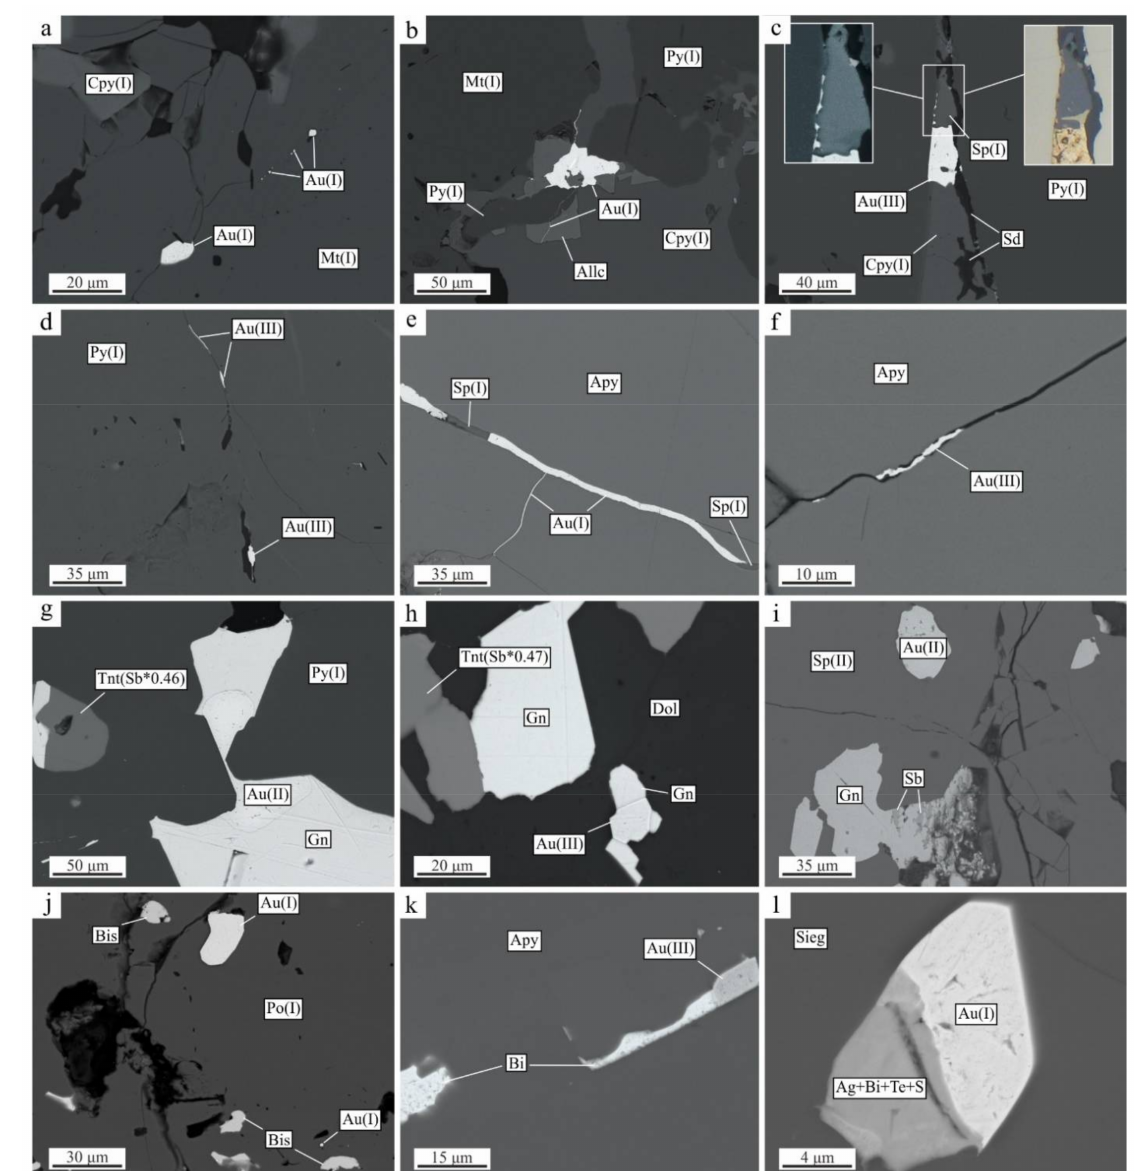
Figure 17. A selection of backscattered electron micrographs showing native gold grains from various districts of the Kultuma deposit. ( a ) The native gold (I) (950‰) micro inclusions in micro fractures in the magnetite (I); ( b ) the native gold (I) (950‰, Hg—0.61 wt.%) grain in contact and pyrite (I) (and gold micro veinlets in alloclasite euhedral grains); ( c ) chalcopyrite (I) and sphalerite (I) in a micro veinlet along pyrite (I) euhedral grains and late native gold grain (III) (650‰, Hg—5.2 wt.%); ( d ) the native gold (III) (620‰, Hg—3.1 wt.%) micro inclusions in micro fractures in the pyrite (I); ( e ) micro veinlet of the native gold (I) (790‰, Cu—1.5 wt.%) with sphalerite (I) in arsenopyrite; ( f ) native gold (III) (620‰, Hg—3.0 wt.%) micro veinlet in arsenopyrite; ( g ) intergrowths of the galena and native gold (II) (800‰, Hg—0.14 wt.%); ( h ) intergrowths of the galena and native gold (III) (560‰, Hg—3.0 wt.%); ( i ) rounded micro inclusion of native gold (II) (880‰) in sphalerite (II); ( j ) micro inclusions of native gold (I) (880‰) and bismuthinite in pyrrhotite (I); ( k ) micro inclusions of native gold (III) (590‰) and native bismuth in micro fractures in arsenopyrite; ( l ) micro inclusions of native gold (I) (870‰, Cu—0.18 wt.%) and compound (Ag + Bi + Te + S?) in siegenite. Abbreviations: Sb*—Sb/(Sb + As); Dol—dolomite; Sd—siderite; Mt—magnetite; Py—pyrite; Apy—arsenopyrite; Cpy—chalcopyrite; Allc—alloclasite; Sieg—siegenite; Po—pyrrhotite; Gn—galena; Sp—sphalerite; Tnt—tennantite; Bis—bismuthinite; Bi—native bismuth; Sb—native antimony; Au—native